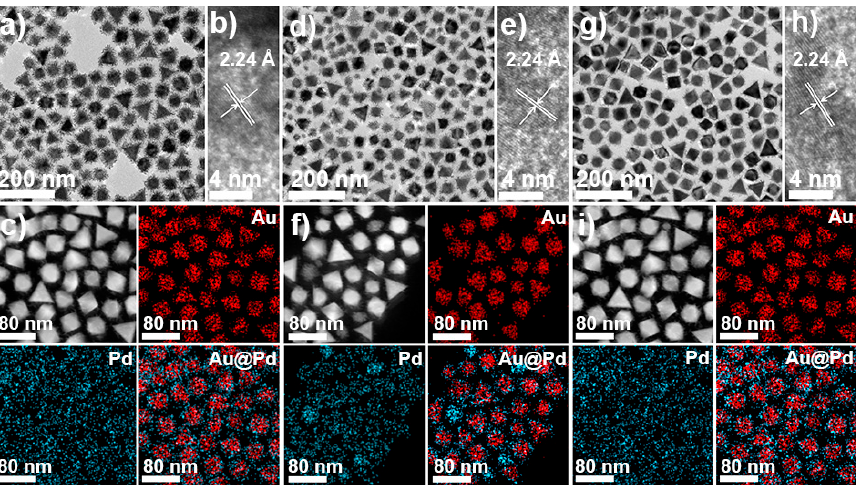
Figure 1. TEM, HRTEM and HAADF − STEM image and corresponding EDS elemental mapping